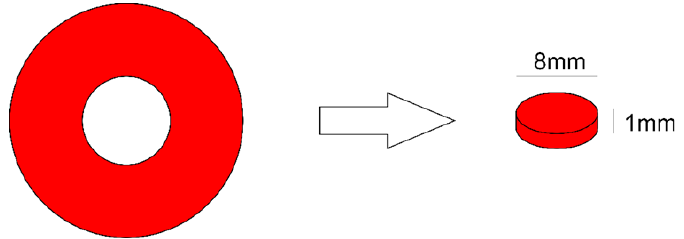
Figure 1. Scheme of the Teflon matrix used to obtain the discs of resin-based composites. Table 2. Sample size (n = 10, following other studies [4,7,13]) according to the shade of RBC and the curing mode.